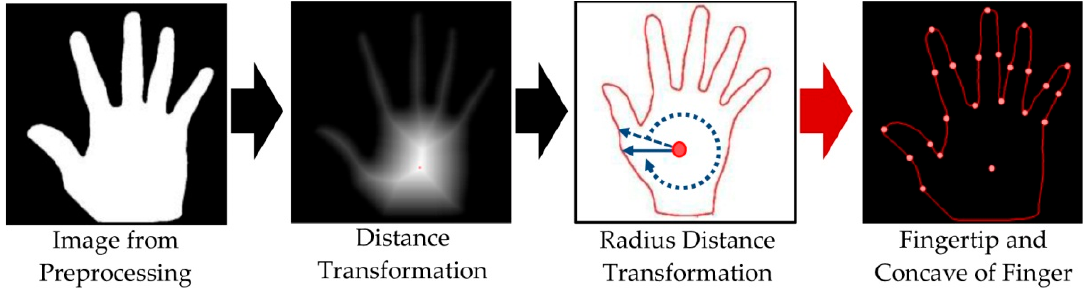
Figure 4. Fiducial points including fingertip and concave point extraction.